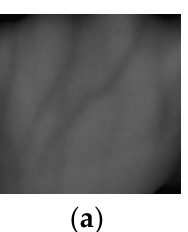
distribution of gray level in images can’t be equal. Thus, we need to normalize gray level from 0 to 255 by formula (1).